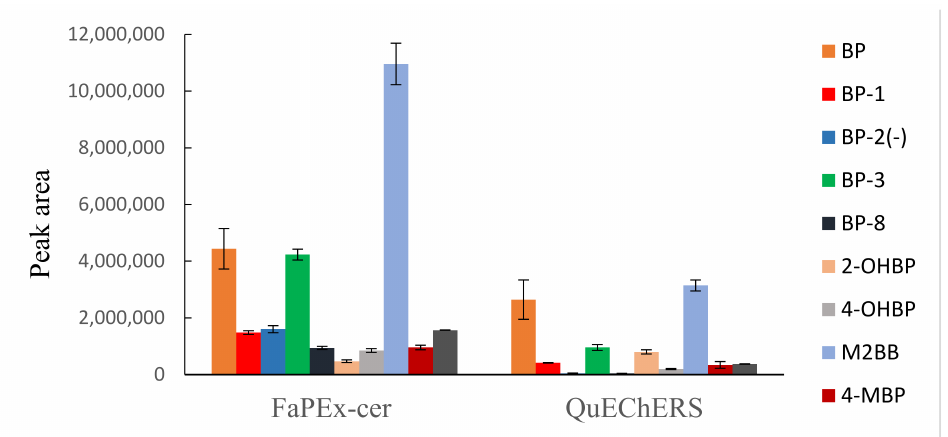
Figure 2. Comparison of FaPEx-cer and QuEChERs methods in rice cereal spiked with standards and ILISs (20 ng/g and 8